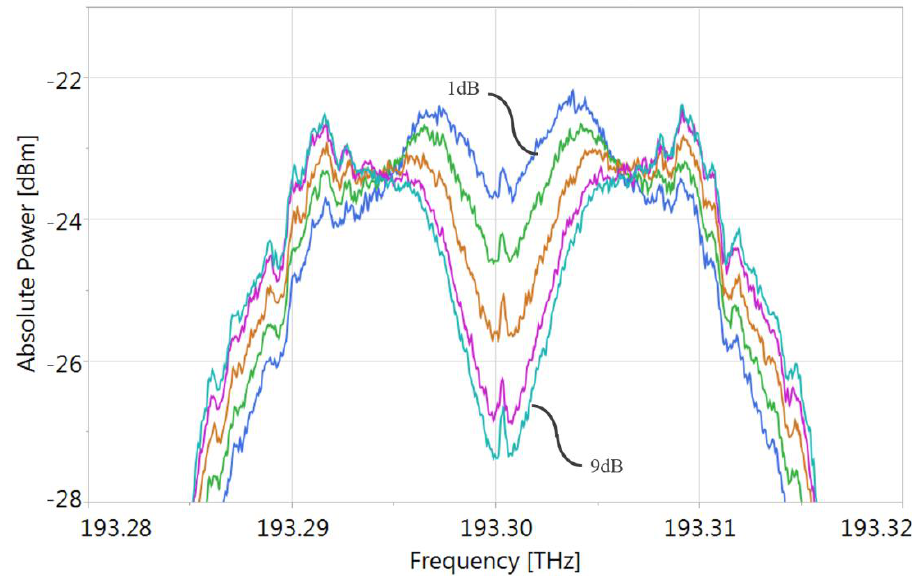
Figure 8. Tx pre-compensation is achieved through the adjustment of FIR filter. The spectra above show the output from the coherent transmitter at different peaking values from 1 dB to 9 dB at 2 dB step size.